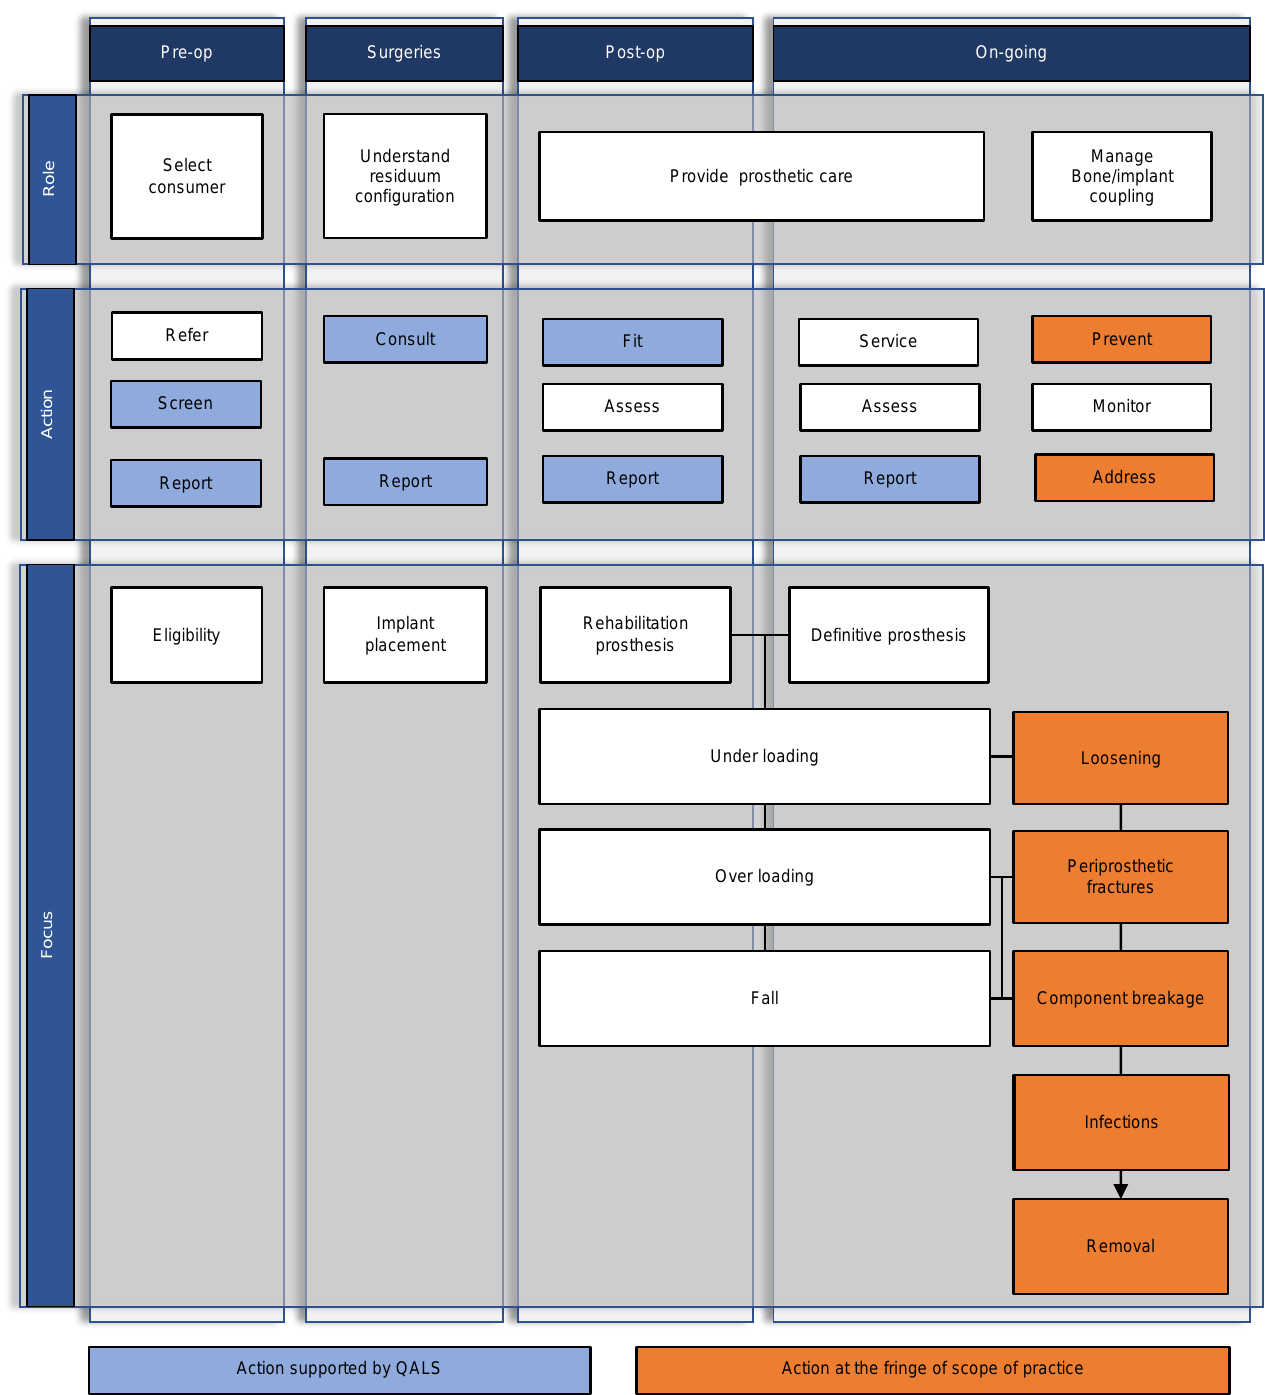
Figure 3: Roles, actions and focus of prosthetic care provided by prosthetists to consumers fitted with transfemoral and transtibial bone- anchored prostheses at various stages of treatment (e.g., pre-op, surgery, post-op, on-going) included tasks supported by Queensland Artificial Limb Service (QALS) and tasks of the fringe of usual scope of practice of prosthetists. Adapted from Frossard et al (2018).